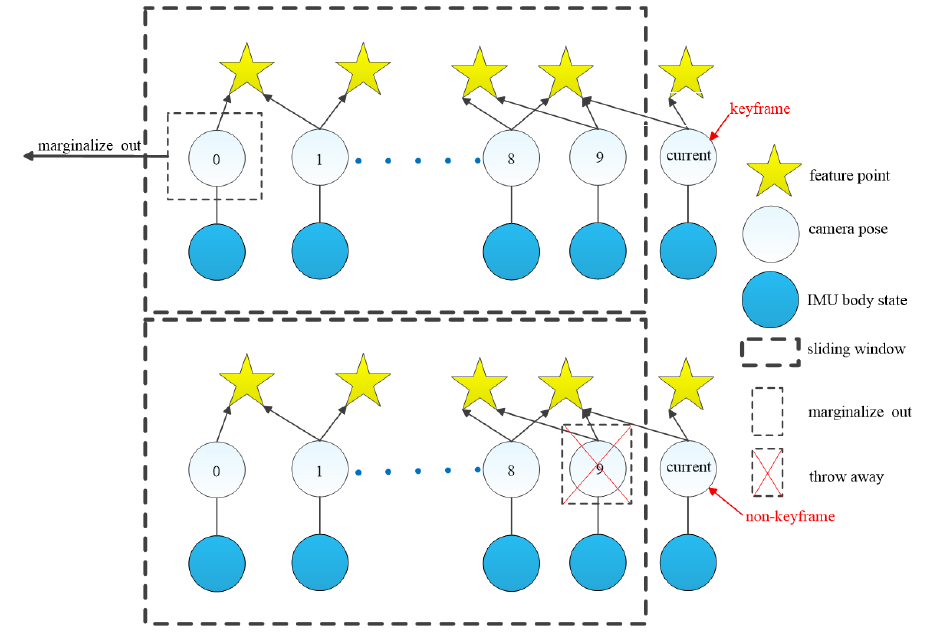
Figure 6. Marginalization strategy of SD-VIS.